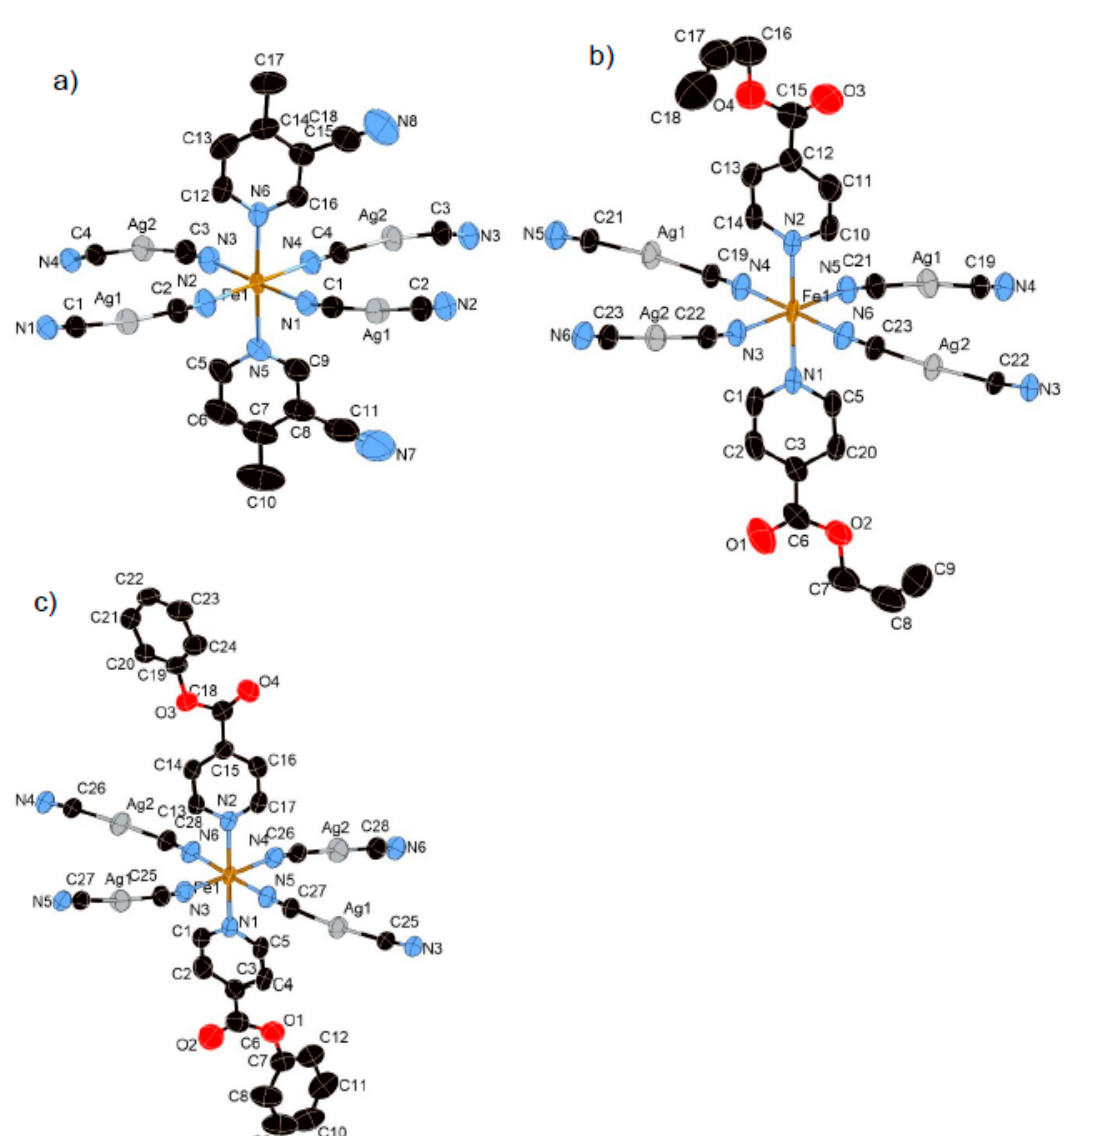
Figure 1. Coordination structures of ( a ) 1 , ( b ) 2 , and ( c ) 3 containing its asymmetric unit (HS state). In these pictures, the hydrogen atoms are omitted for clarity.